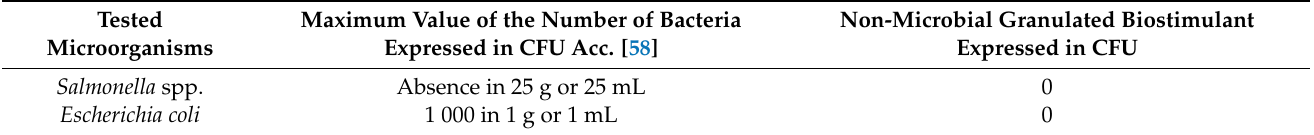
Table 4. Microbiological analyses of non-microbial granulated plant